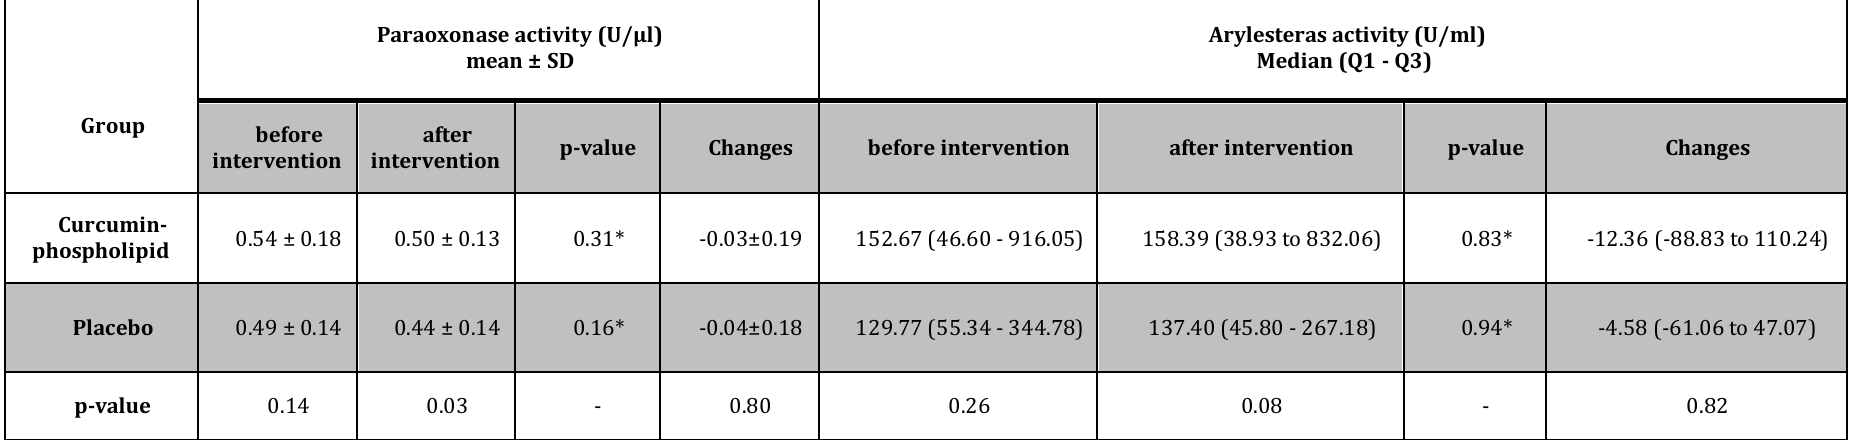
Table 2 : Comparison of paraoxonase activity and arylesteras activity between the curcumin-phospholipid group and placebo group before and after 6 weeks